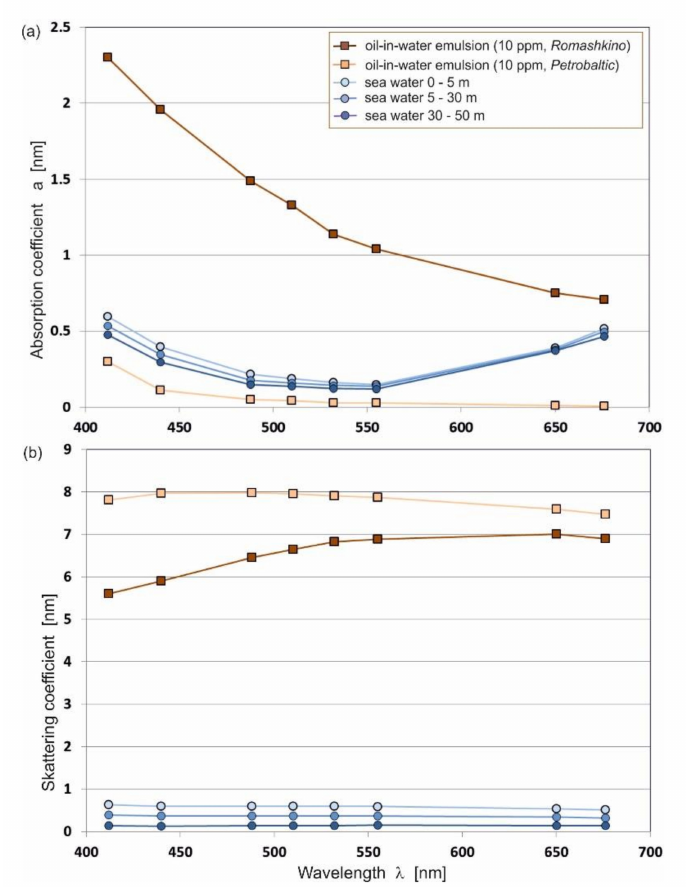
Figure 1. Spectra of both the absorption coefficient ( a ) and the scattering coefficient ( b ) of seawater and oil-in-water emulsions (10